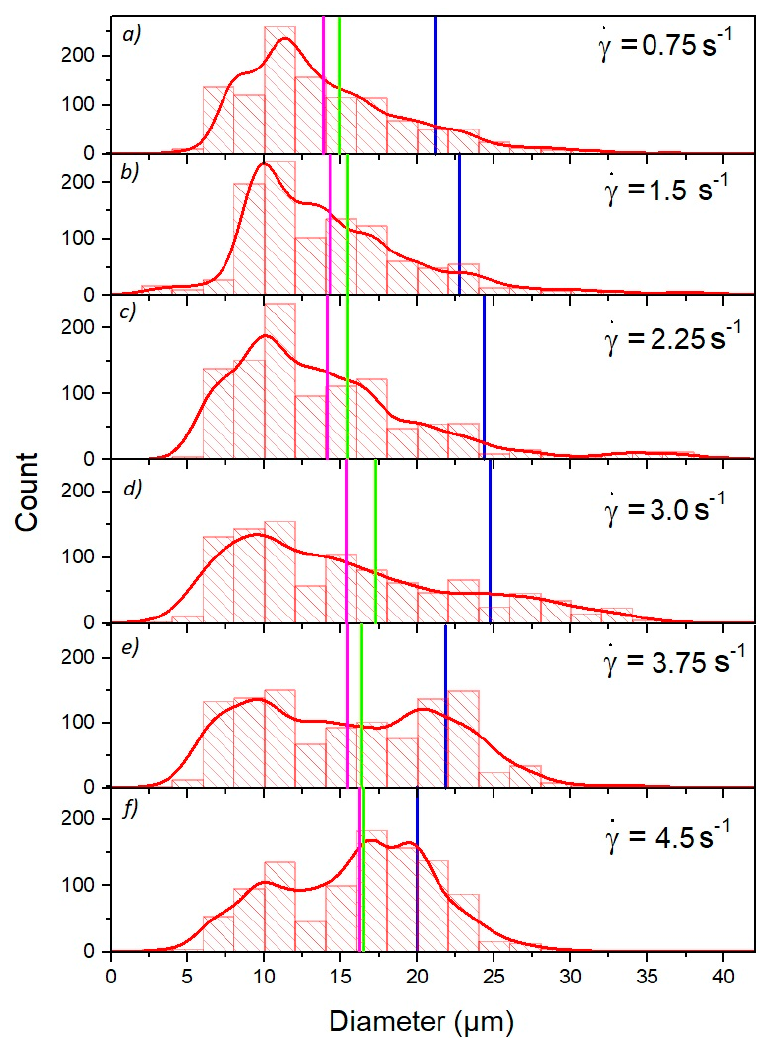
Figure 3. Droplet size distribution and the smoothing kernels for all shear rates studied. For the first three (lower) shear rates ( a – c ), the size distributions are characterized by a single peak and positive Kurtosis [34–37]; with rather broad distributions. The magenta bar corresponds to the mean diameter for the distribution, the green bar to the D 2,0 value, and the blue bar corresponds to the value of D 4.3 . In histogram ( d ), the maximum value of D 4.3 is reached (see Table 1). Histograms ( e , f ) show a rapid decrease in the value of D 4.3 , characteristic of distributions with a high top and a smaller contribution from outliers.